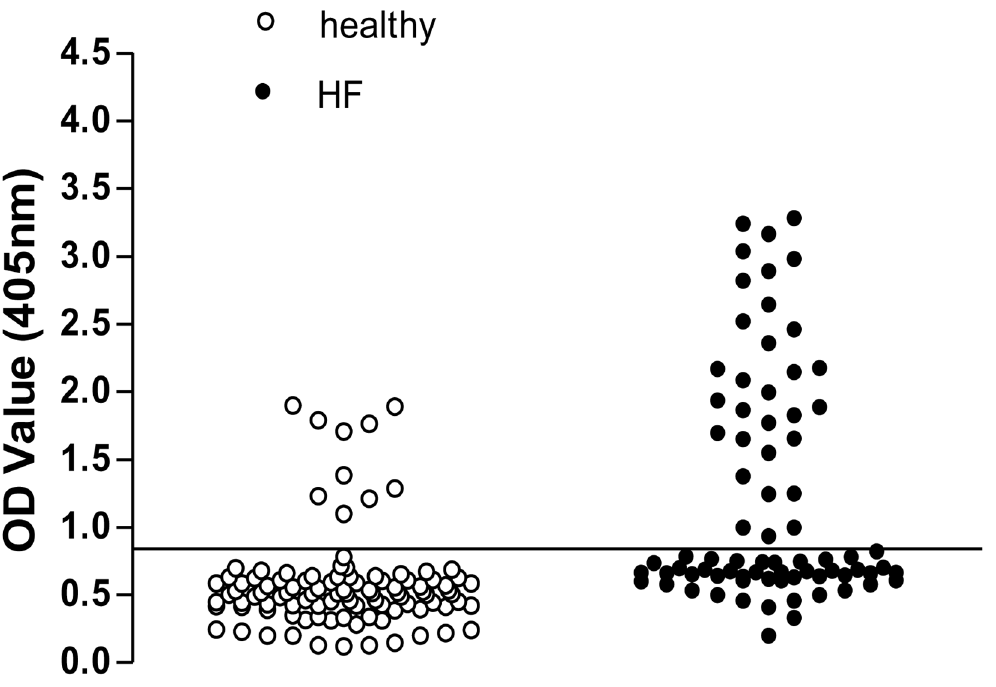
Figure 1. Detection of β -AR Abs in HF patients and healthy subjects. Scatter diagram demonstrating optical density values 3 (dilution of 1:10) for detecting β -AR Abs in each serum sample from 76 HF patients and 100 healthy subjects. 3